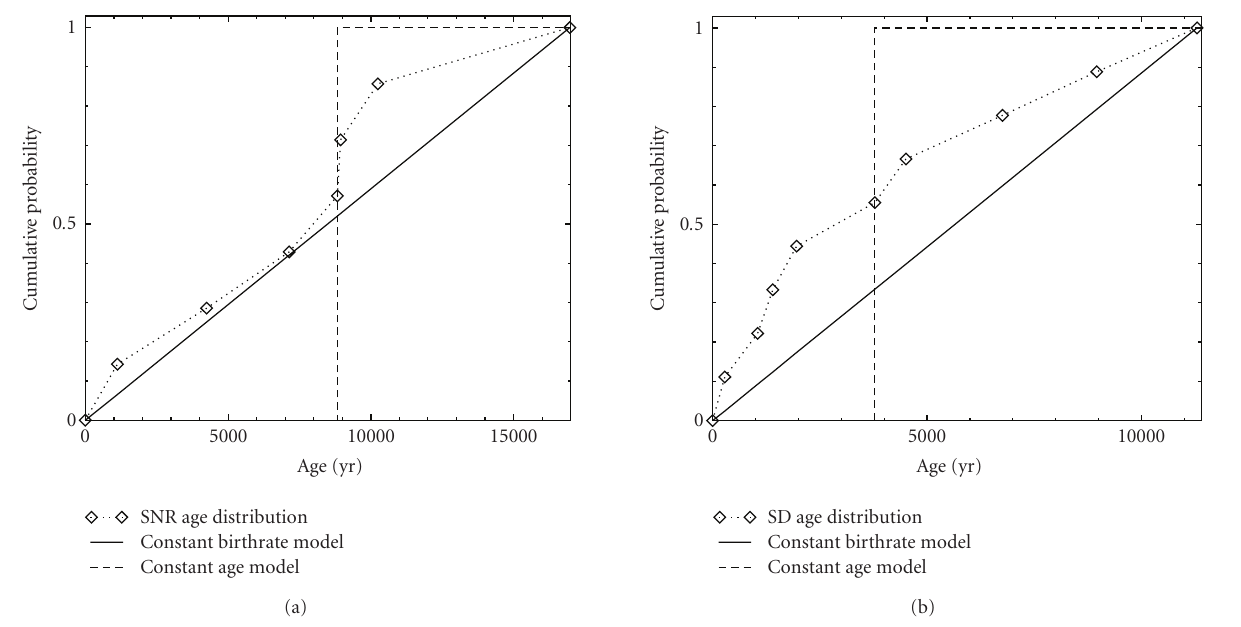
Figure 1: (a) shows the cumulative probability distribution for ages of SNRs associated with AXPs/SGRs (diamonds). Also shown is the expected probability distributions for the cases of constant birth rate (solid line) and of constant age (dashed line). (b) shows the cumulative probability distribution for spin-down ages of AXPs/SGRs (diamonds) and expected probability distributions for constant birth rate (solid line) and of constant age (dashed line) models. The ages for the constant age models were chosen to give minimum KS statistic (and lowest rejection probability) for both SNR and spin-down